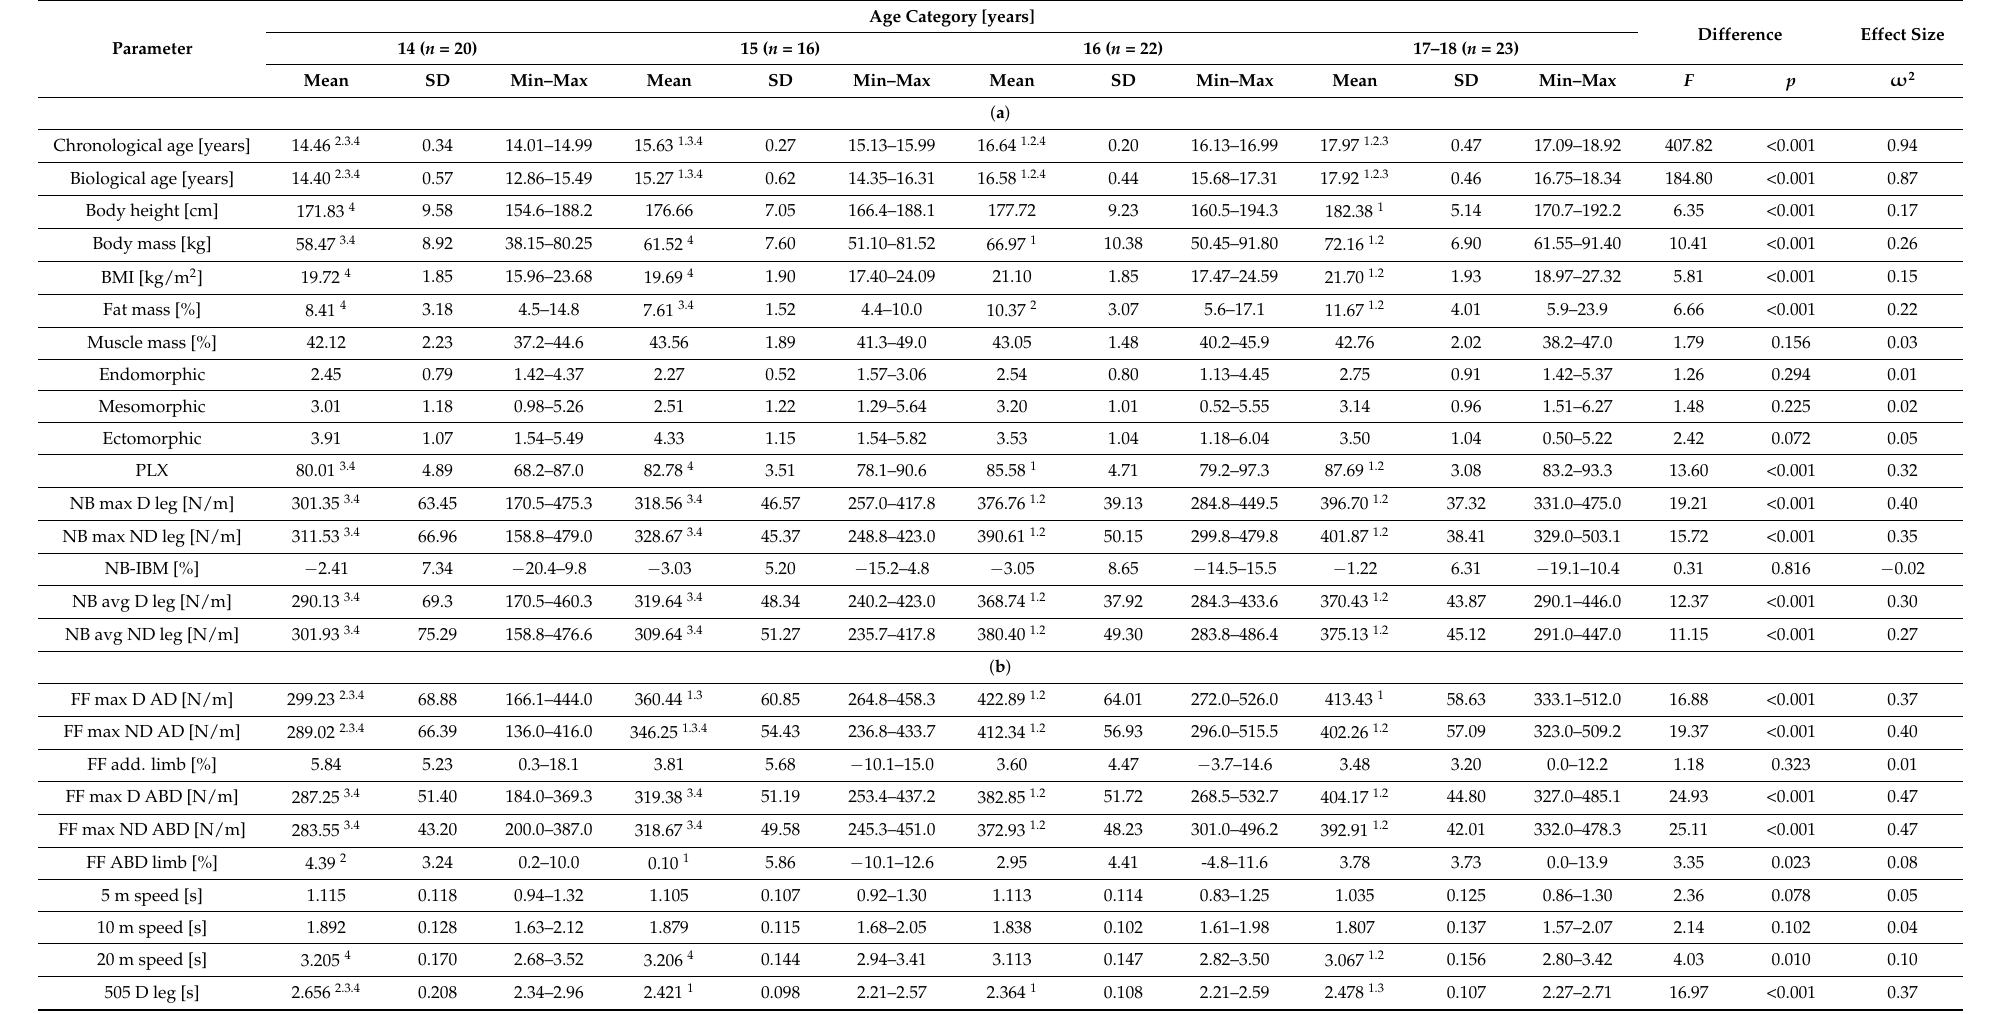
Table 1. ( a ) Descriptive and comparative analysis of chronological and biological age and the anthropometric characteristics of soccer players in the four analyzed age categories. ( b ) Descriptive and comparative analysis of the physiological and performance parameters of soccer players in the four analyzed age